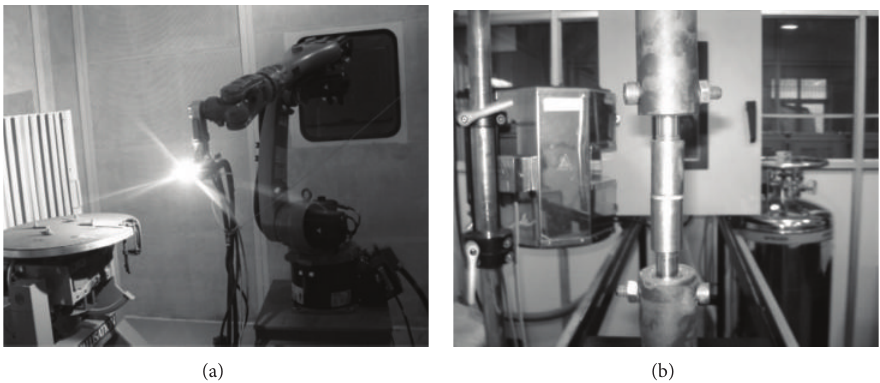
Figure 4: Plasma spraying torch and adhesion test setup as per ASTM C-633 standard.